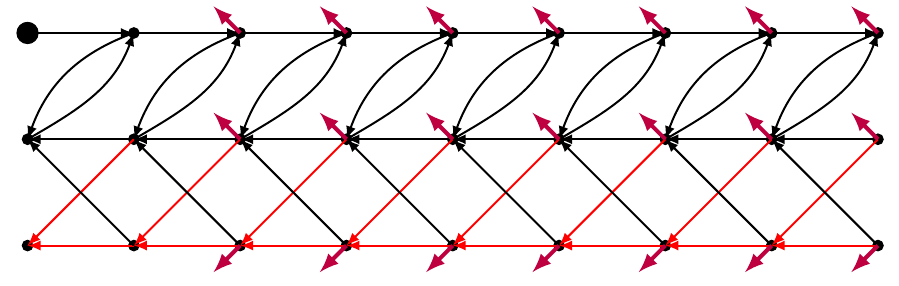
Figure 5: Three layers of states according to the type of steps leading to them (up, down-black, down-red). Purple arrows all end in the